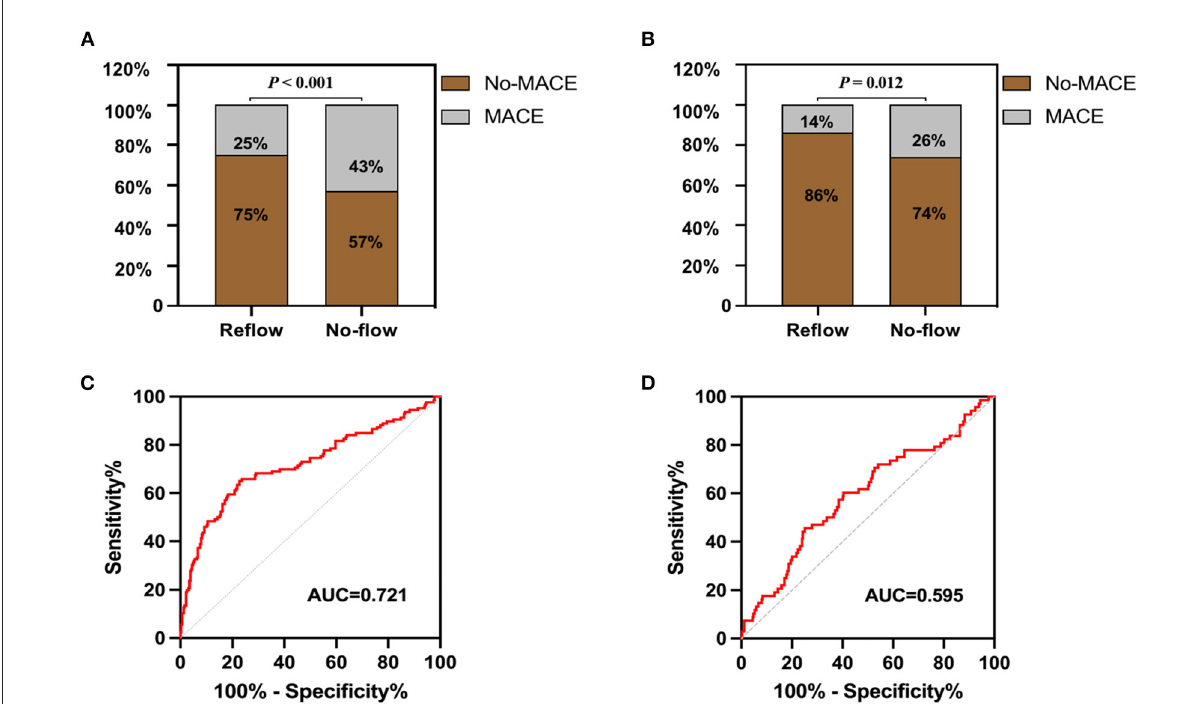
FIGURE4 In-hospital and 1-year post-discharge MACE after primary PCI in patients with STEMI. (A) Comparison of MACE in hospital between groups. (B) Comparison of MACE in 1 year after discharge between groups. (C) Receiver operating characteristic curve of nomogram model for predicting the occurrence of in-hospital MACE. (D) Receiver operating characteristic curve of nomogram model for predicting the occurrence of 1-year post-discharge MACE.